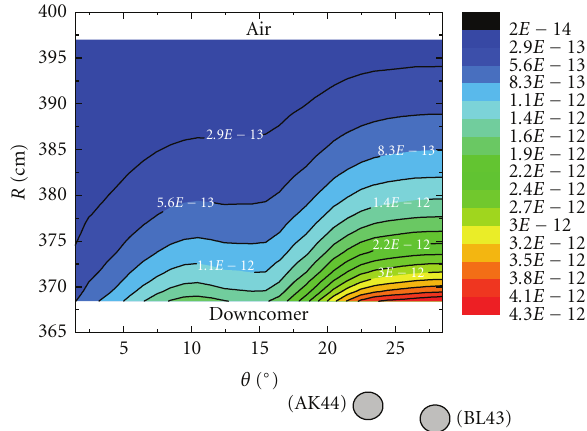
Figure 9: Rate of DPA on the RPV in terms of R and Theta for Z = 33 . 75cm with maximum DPA.